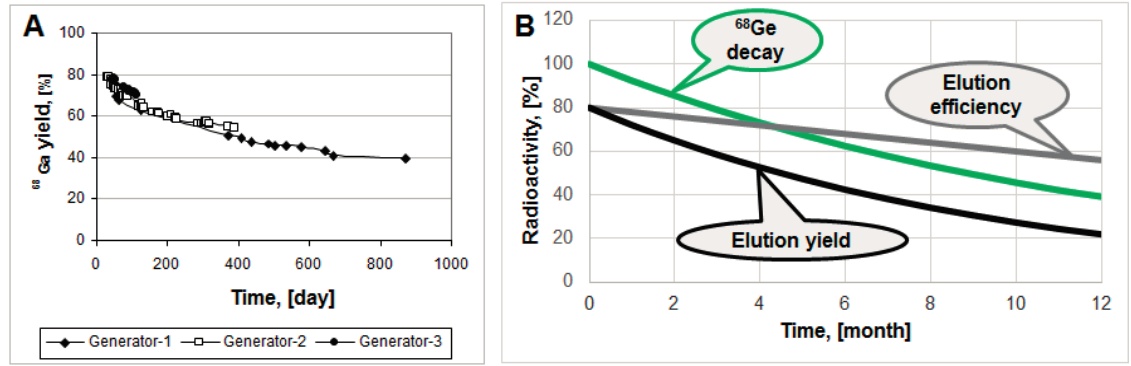
Figure 4. ( A ) 68 Ga elution yield for Generator-1 over 29 months, Generator-2 over 14 months and Generator-3 over three months; ( B ) Hypothetical graphs representing 68 Ge decay, elution efficiency and resulting non-decay corrected elution yield.